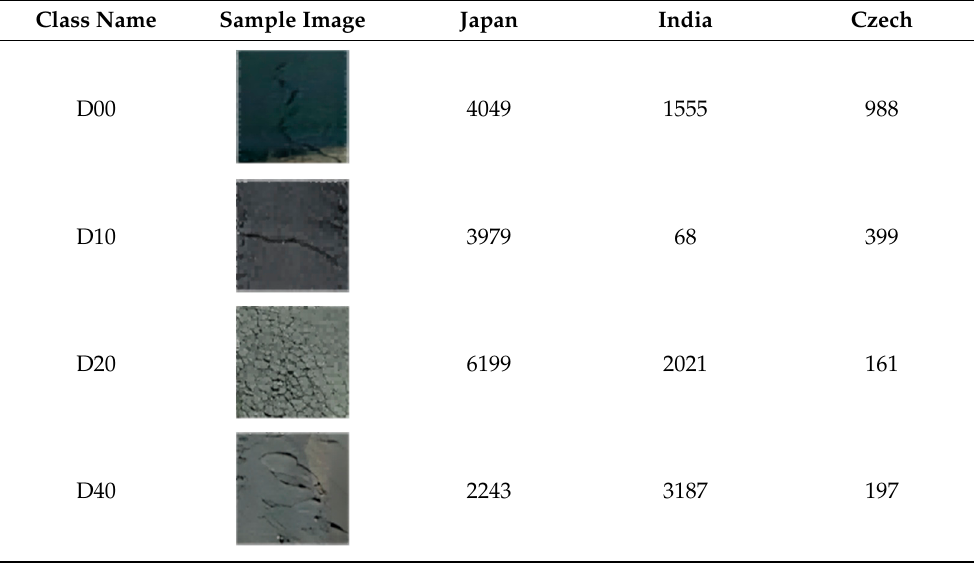
Table 2. RDD-2020 dataset.